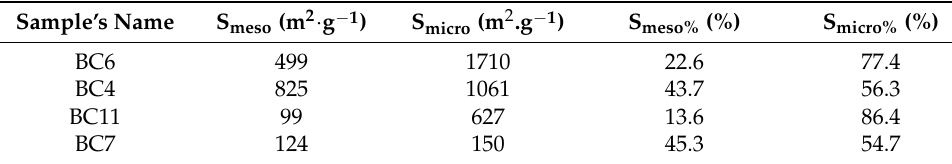
Table 3. Microporosity and mesoporosity data of the four selected